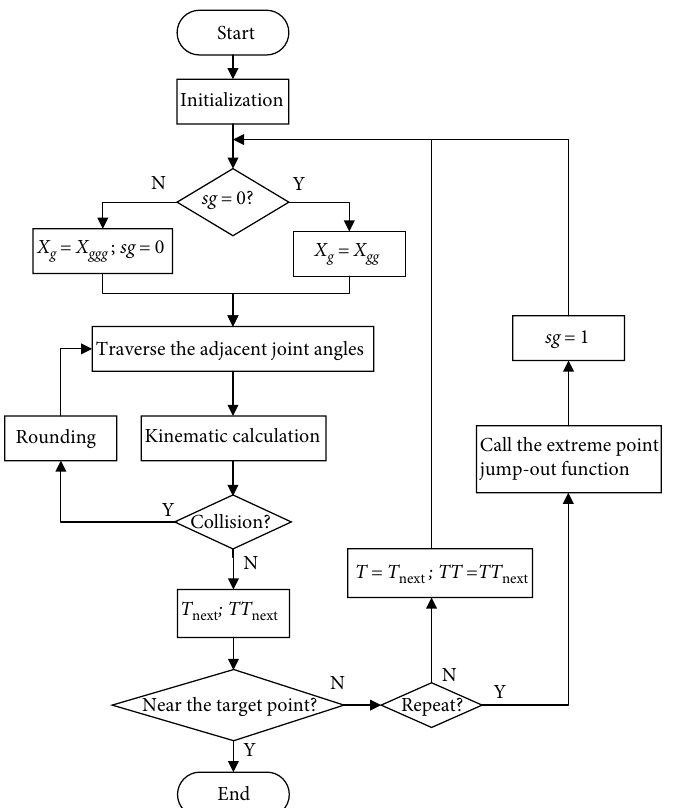
Figure 1: Flow chart of the obstacle avoidance path planning of the manipulator.